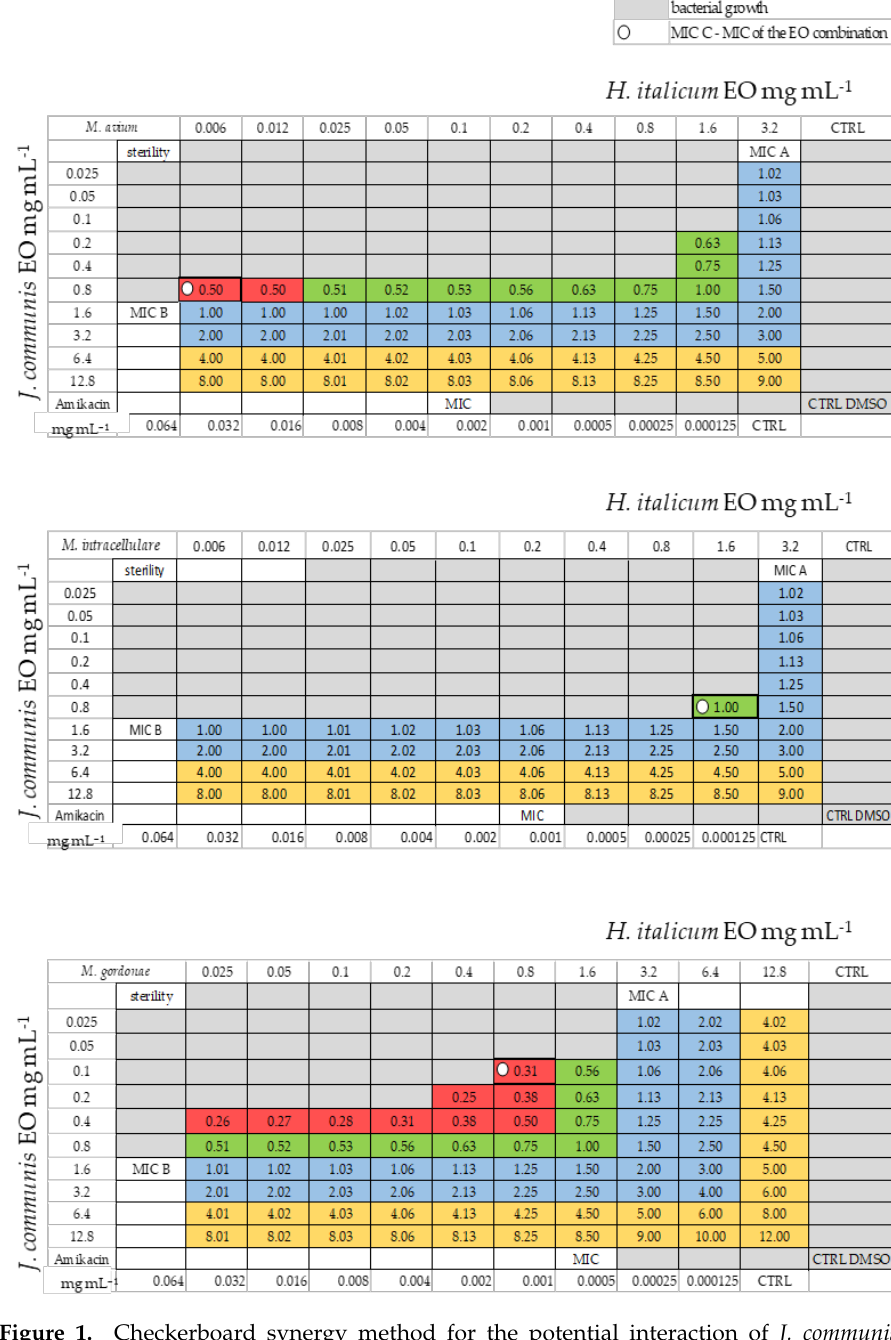
Figure 1. Checkerboard synergy method for the potential interaction of J. communis and H. italicum EOs on nontuberculous mycobacteria (NTM). MIC—minimal inhibitory concentration; FIC—fractional inhibitory concentration; FIC i —fractional inhibitory concentration index; CTRL—control; EO—essential oil.